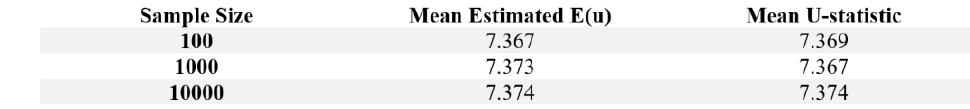
Table A0. Mean estimated E(u) and mean U across 100,000